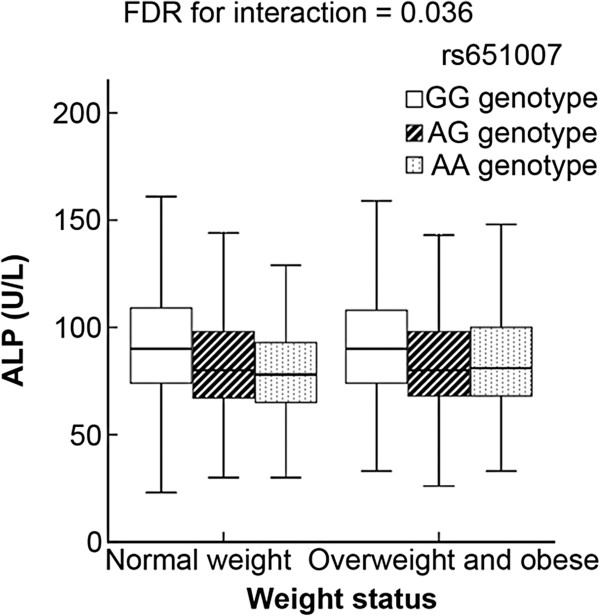
Box plot for interaction between rs651007 genotypes and overweight and obesity. The vertical axis shows serum ALP concentrations while the horizontal axis shows the BMI status (normal weight/overweight and obese). Minor allele A diminished serum ALP levels but this effect was attenuated in overweight or obese individuals.